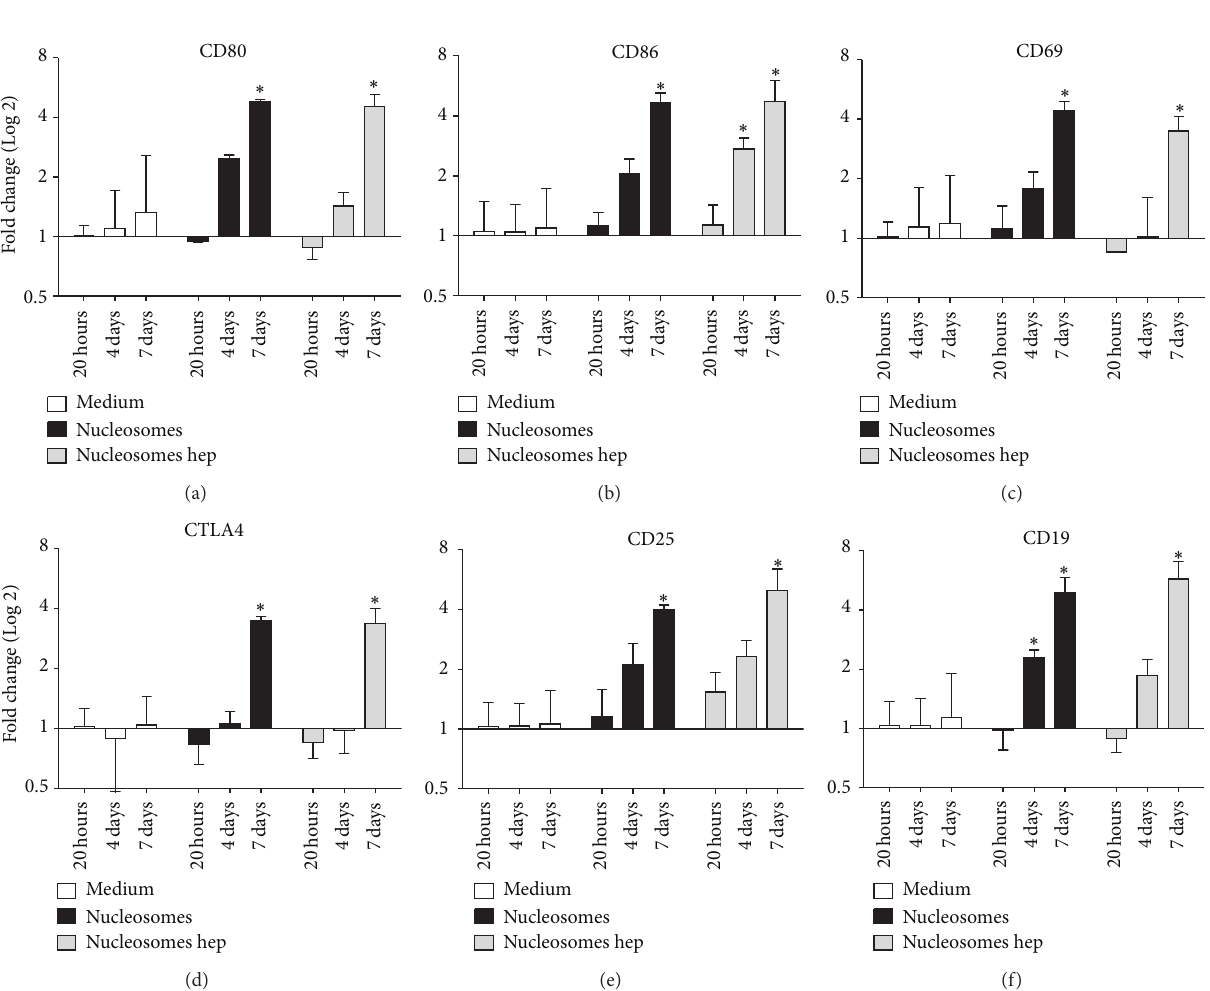
Figure5:ThemRNAlevelsofleukocyteactivationmarkersinnucleosome-andnucleosome/heparin-stimulatedsplenocytesfromanephritic mouse. The mRNA levels of CD80 (a), CD86 (b), CD69 (c), CTLA-4 (d), CD25 (e), and CD19 (f) are all upregulated over time in response to stimuli with nucleosomes and nucleosomes/heparin. Expression levels for each gene, measured by qPCR, were normalized against the expression level of TBP. Data are given as Log2 of mean ± SEM of fold change values normalized against medium stimulated cells and are representative for at least three independent analyses. Fold change is shown as mean of triplicates ± SD. ∗ Statistically significant ( 𝑃 < 0.05 ) change in mRNA levels compared to medium stimulated cells at the same time